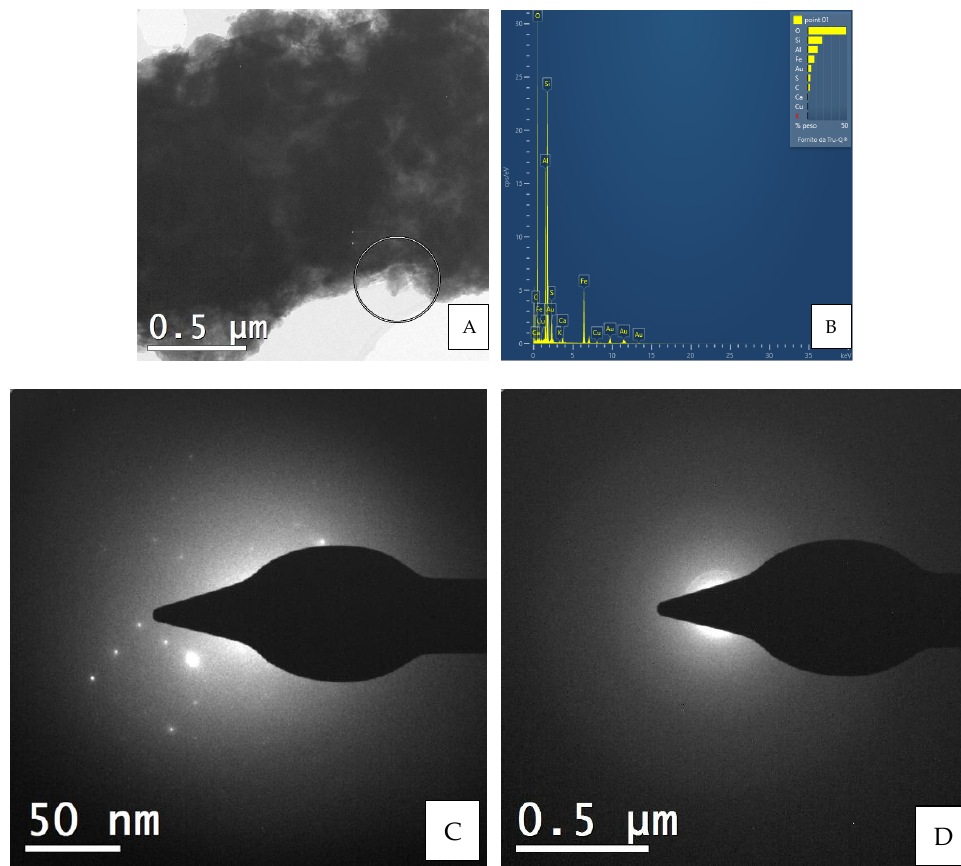
Figure 6. XRPD pattern of FA4-L precipitates and qualitative analyses for content of mineralogical phases.